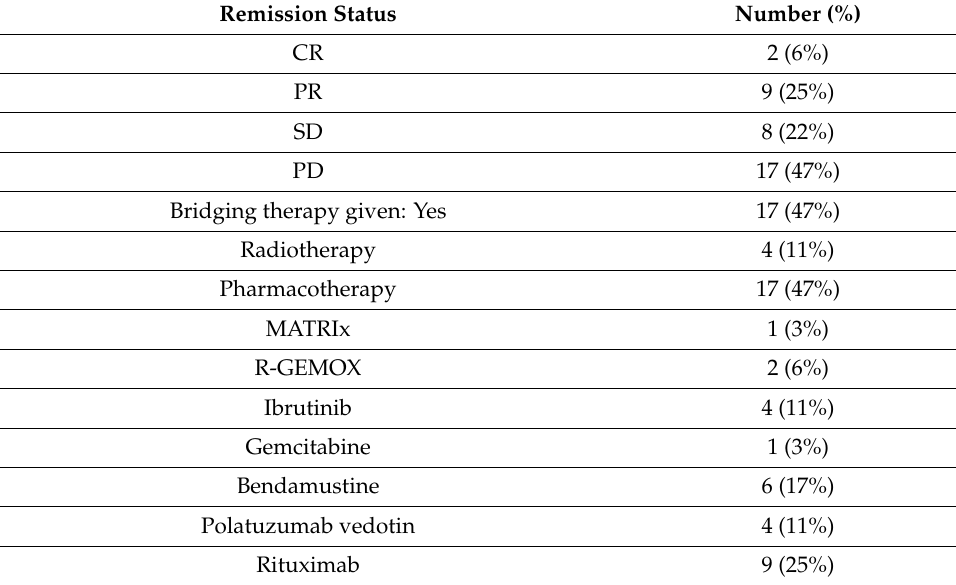
Table 2. Clinical status of the patients at the time of CAR-T-cell